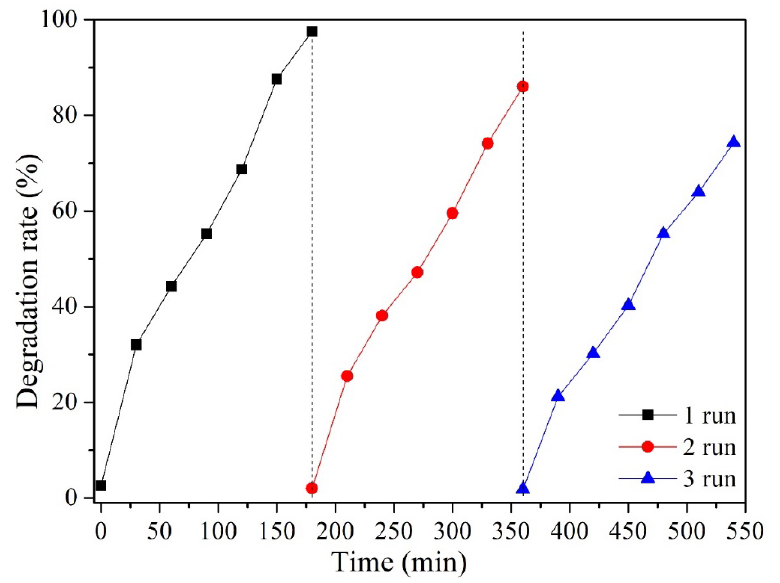
Figure 8. Evaluation of the degradation rate for methyl orange solution over UV irradiation NC10– TiO 2 nanocomposites for three consecutive cycles.